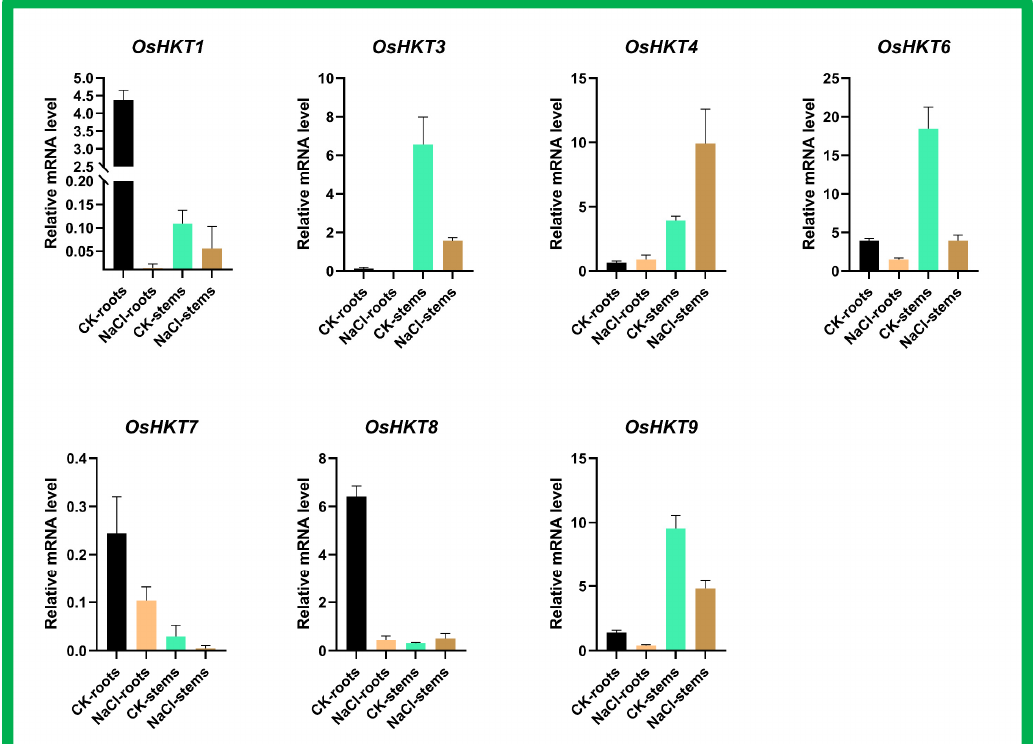
Figure 10. Expression analysis of the OsHKT gene family in rice roots and stems under saline conditions. Different treatments were represented with different colors. ANOVA was used to test significance. p < 0.05. Error bars represent standard deviation.